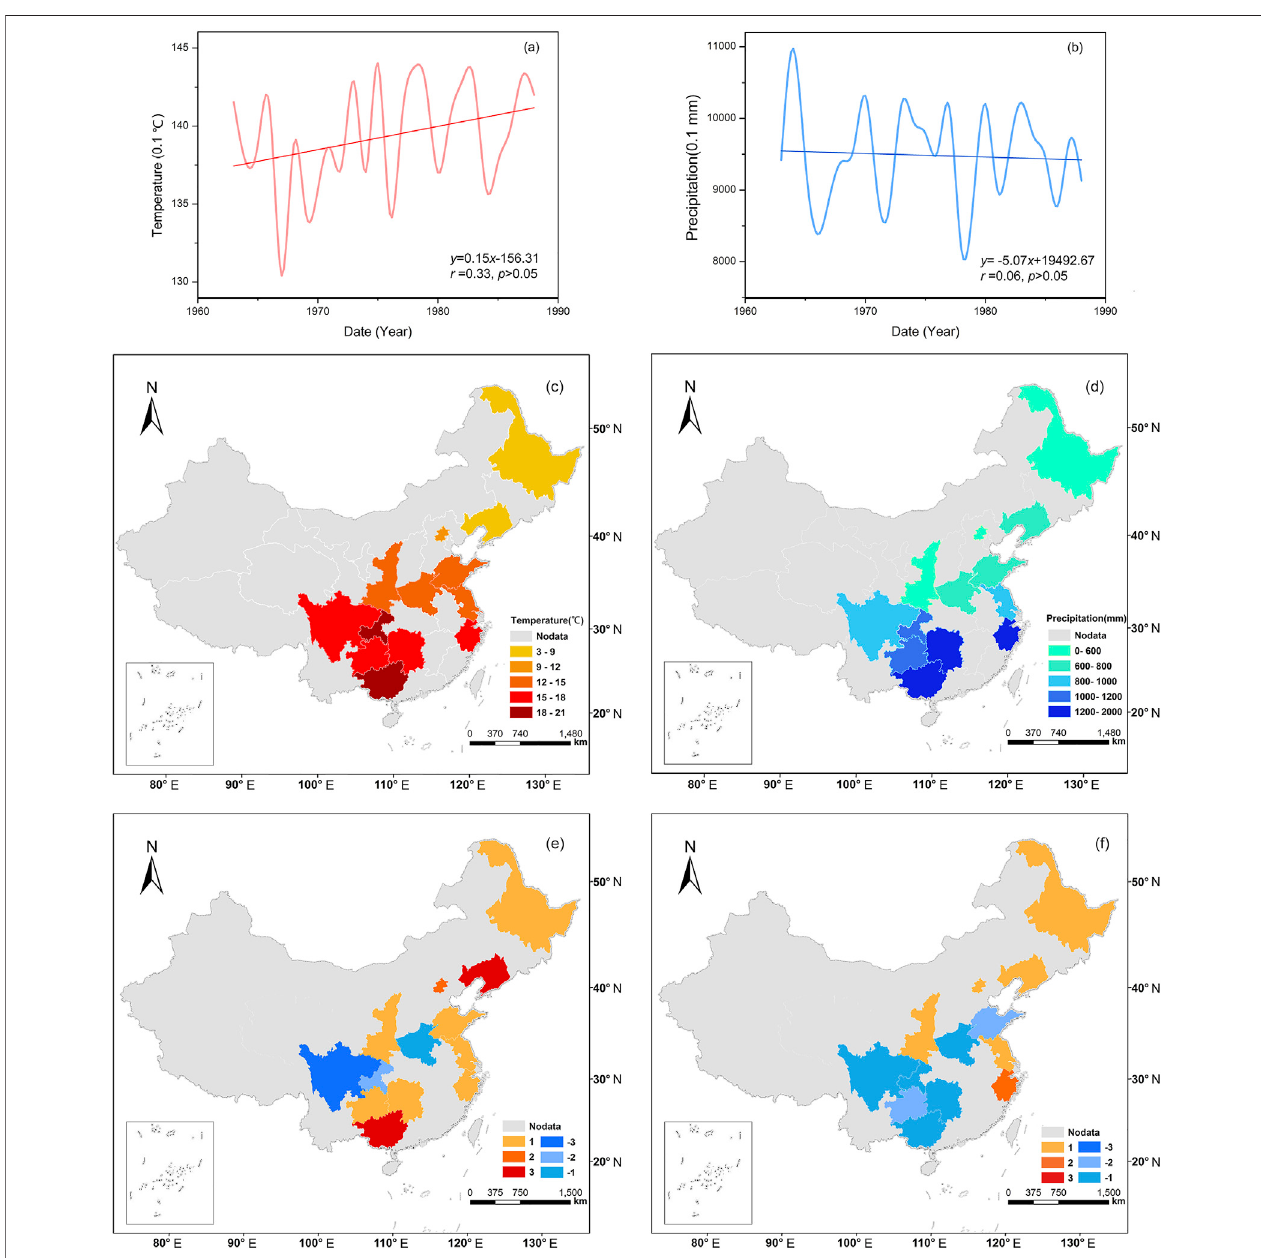
FIGURE 2 | The spatiotemporal dynamics of climate at the study sites (1963 – 1988). (A) Inter-annual average temperature variation curves of the mean values across all study sites. (B) Inter-annual total precipitation variation curves of the mean values across all study sites, (C) Spatial distribution of mean annual temperature (MAT). (D) Spatial distribution of mean annual precipitation (MAP), (E) Spatial distribution ofthe change trend in MAT, (F) Spatial distribution of the change trend inMAP. Thelightgrayareasinthe fi guresrepresenttheareaswithnodata;thebluearearepresentsthedecliningtrend;theredarearepresentstheincreasingtrend,andthe color from light to dark indicates the increasing signi fi cance ( ± 1: p > 0.05, ± 2: p < 0.05, ± 3: p < 0.01).